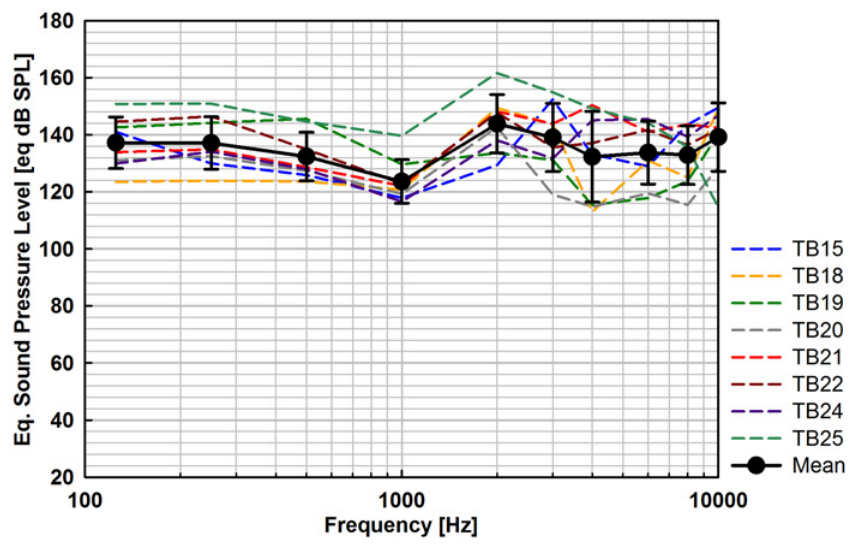
Fig 6. Eq. sound pressure level output (N = 8) of Codacs stimulation with the Omega/Aerial prosthesis at the SFP for nominally 1 V rms actuator input voltage.